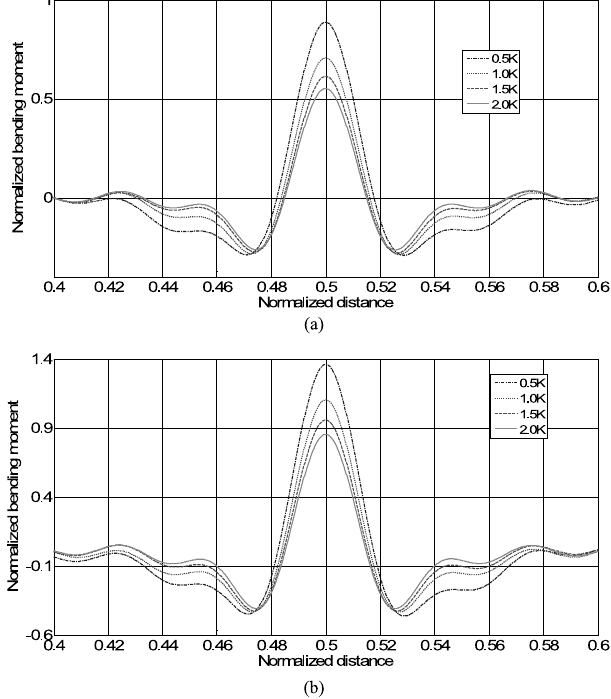
Fig. 8. Effect of foundation stiffness on dynamic bending moment responses at a constant speed of 88.25 km/h; (a) moving load (b) moving mass.